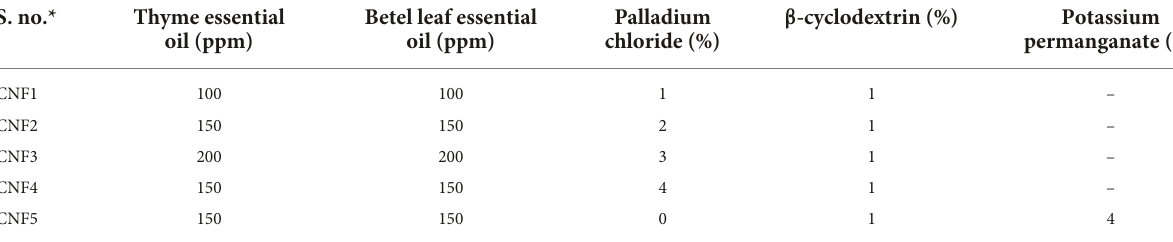
from 0 to 100 (black to white), and a ∗ and b ∗ indicate the colour ranges from green to red and blue to yellow from negative to positive on the horizontal and vertical axes, respectively. From these L ∗ , a ∗ , and b ∗ values, the total colour change ( (cid:49) E),